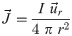
Current source: A current in an homogenous medium yields a current source density flowing in all directions.The current density writes: J→=Iu→r4πr2, where r is the distance to the current source and I the current generated at the origin. The Ohm law (J→=σE→) leads to the potential V=I4πσr created at any distance r.